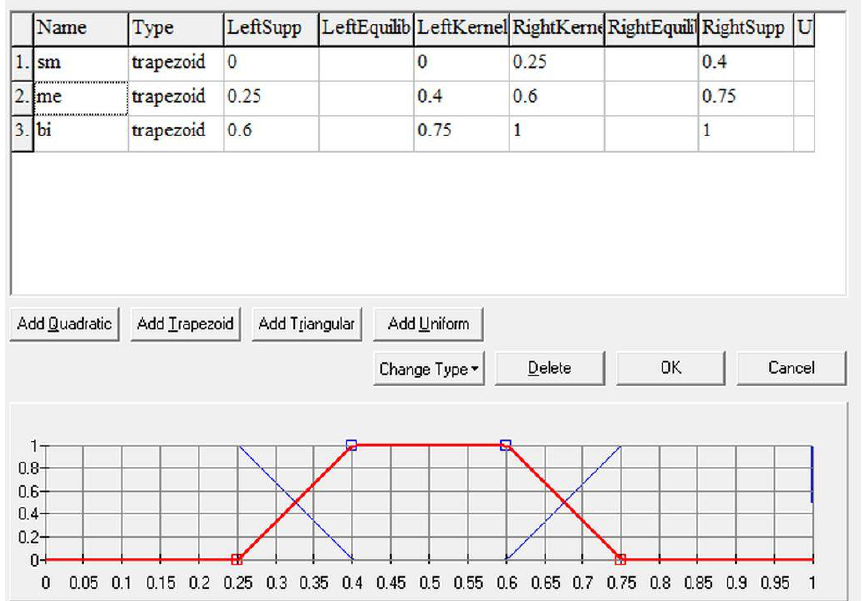
Figure 2. Graphic representation of the input value set V1.